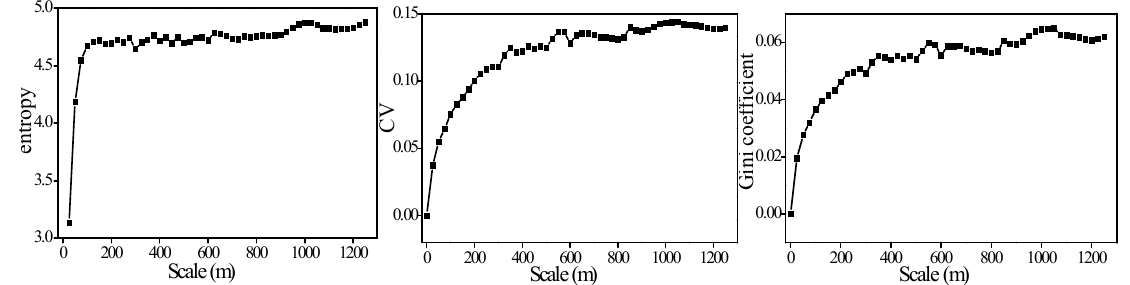
Figure 7. Variation of the three methods when the LST scale is expanded. Note: The abscissa indicates the length of the study area that gradually increases from the upper left corner of Figure 5c with a gradient of pixels 5i × 5i (i = 0, 1, 2 … 50).